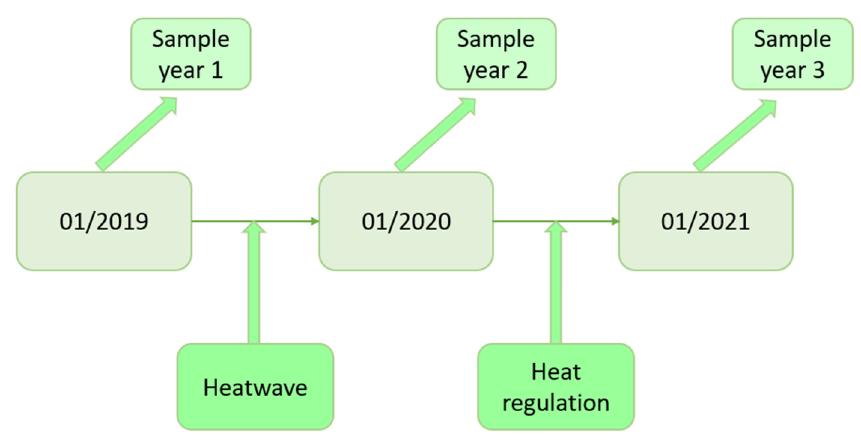
Figure 1. Timeline of experimentations and events at the production facility.